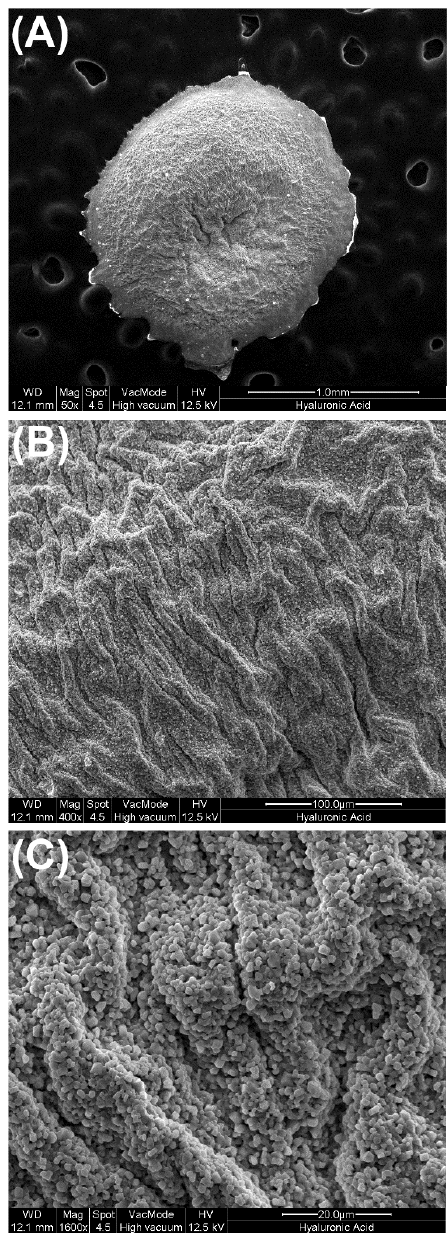
Figure 1. Scanning electron microscopy (SEM) of hyaluronic acid scaffolds at ( A ) low and ( B ) high magnification. Notice the roughened surface topography of the cross-linked HA apparent at very high magnification ( C ).